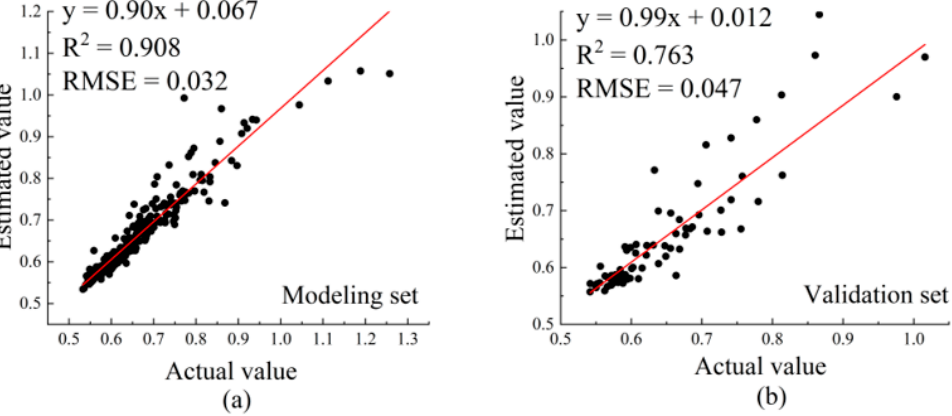
Figure 7. Fi tt ing analysis of estimation results of RF model: ( a ) modeling set; ( b ) validation set.